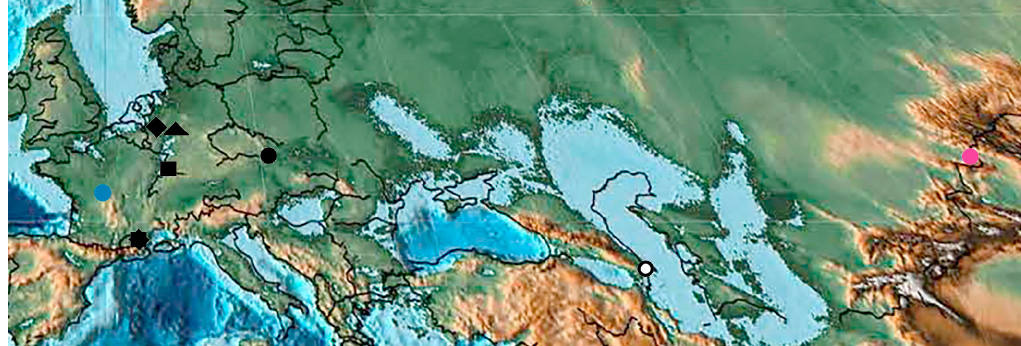
Figure 21. Middle and late Oligocene Curculionoidea deposits: circle—Luzice; rhombus—Rott and Enspel; octagon—Aix-en-Provance; pink circle—Ashutas; ring—Perekishkyul’; triangle—Sieblos; square—Kleinkembs; blue circle—Gaube and Puy-Saint-Jean.